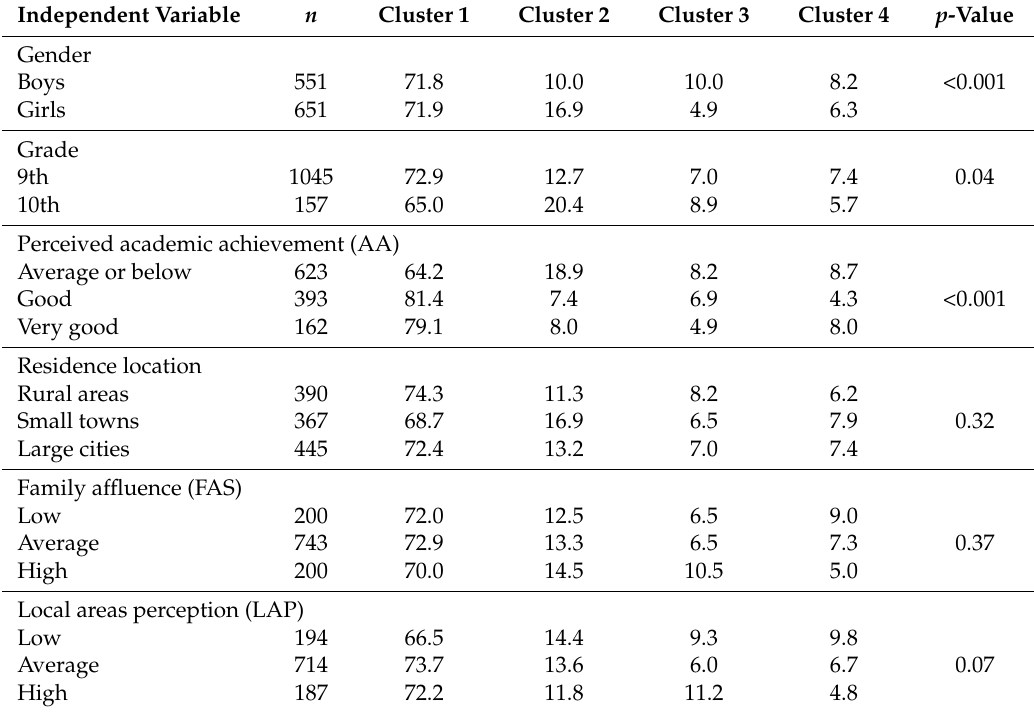
* Description of clusters as in Table